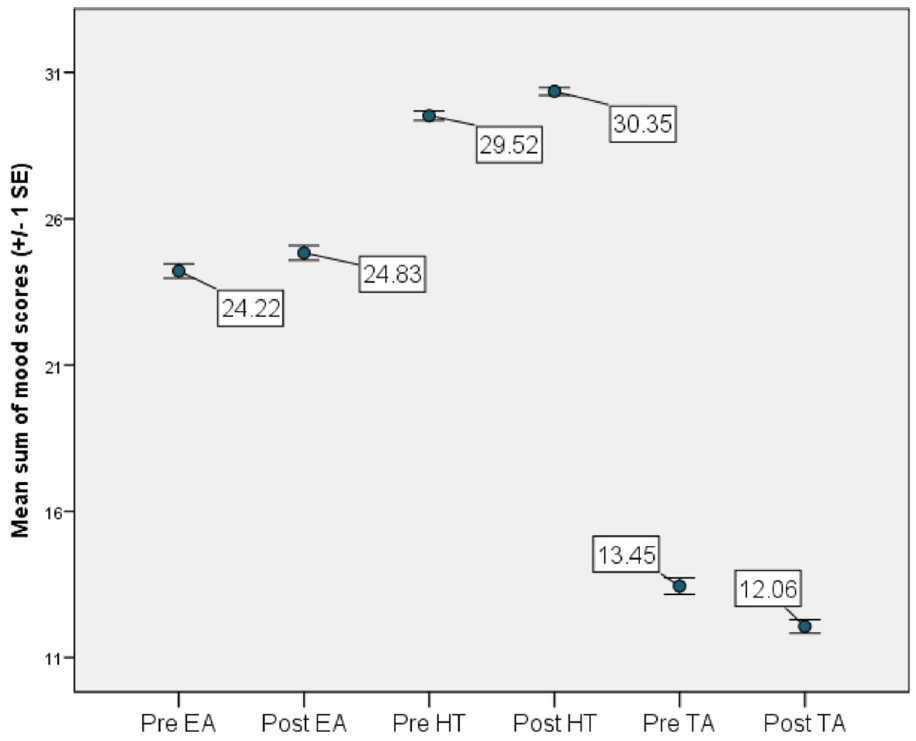
Fig 6. Study participant average UMACL scores for tense arousal (TA), energetic arousal (EA), and hedonic tone (HT) before and after the River’s Edge experience at the Saint Louis Zoo.